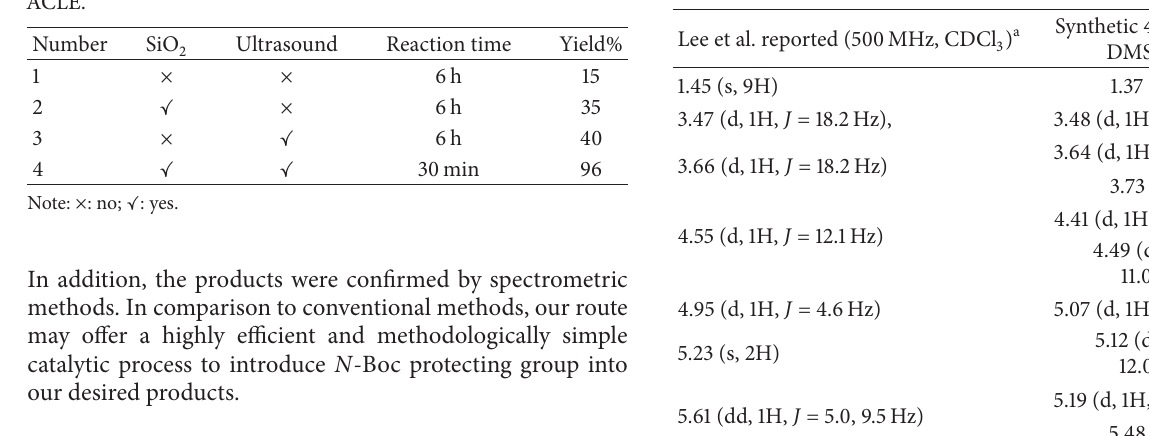
Table 3: Comparison of 1 H NMR data ( 4a